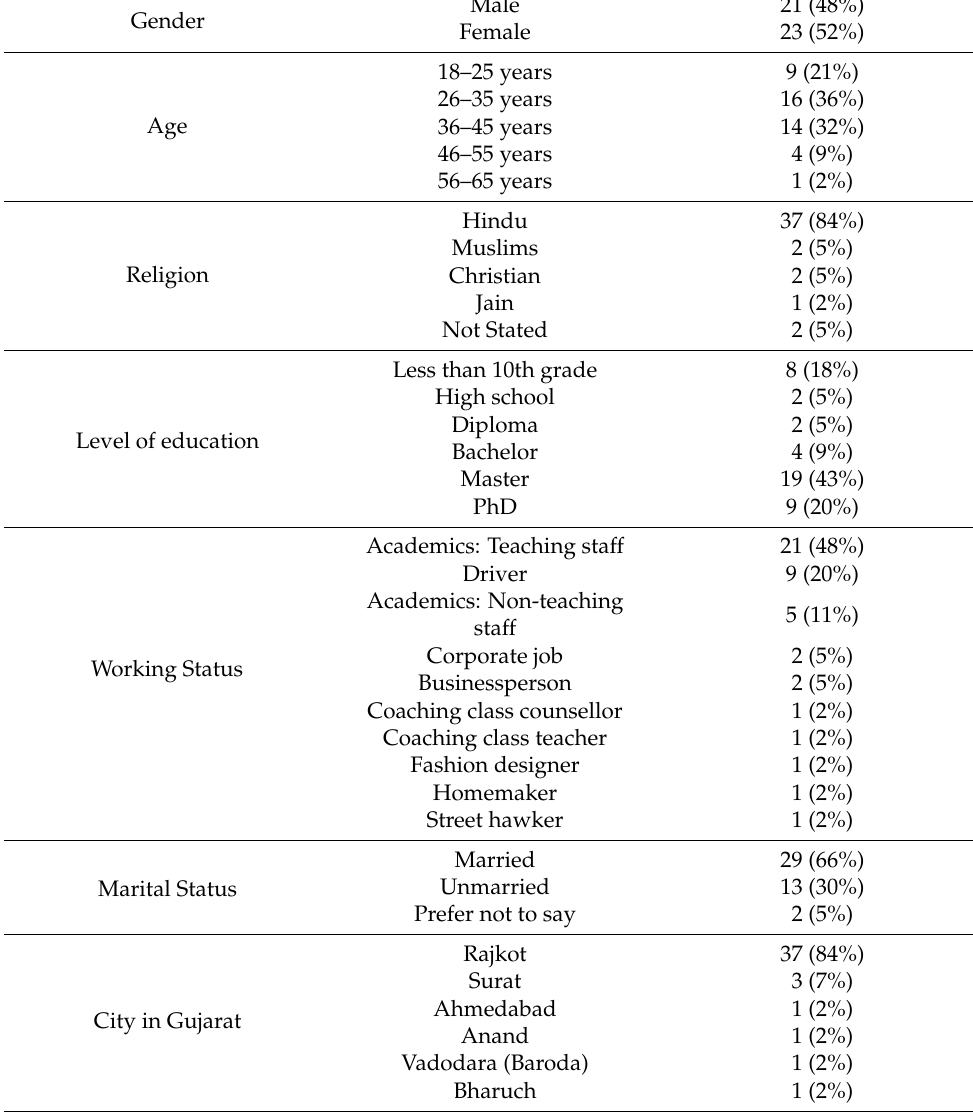
Table 1. Demographics of participants (n =